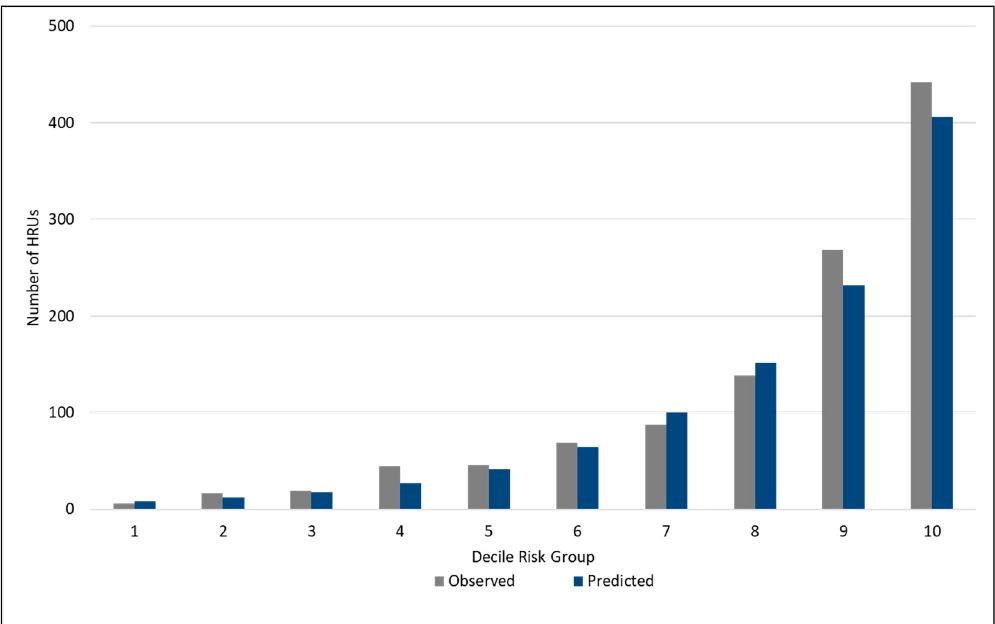
Figure 1. Calibration plot for the High Resource User Population Risk Tool (HRUPoRT) model in the external validation cohort.